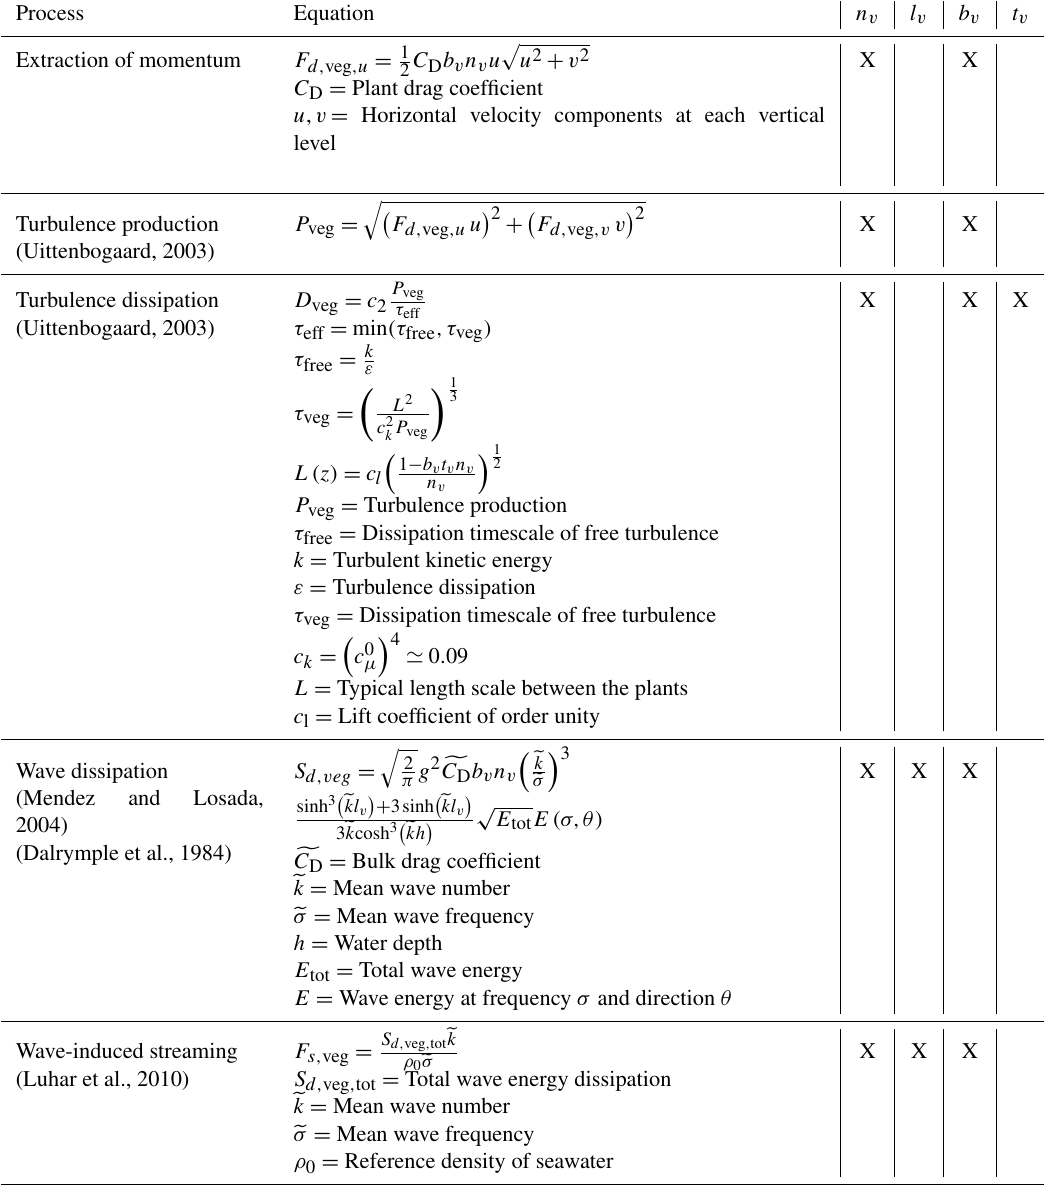
Table 1. Processes in ROMS and SWAN to model the presence of vegetation. The different input parameters (stem density, n v ; height, l v ; diameter, b v ; and thickness, t v ) affecting model wave and hydrodynamics are